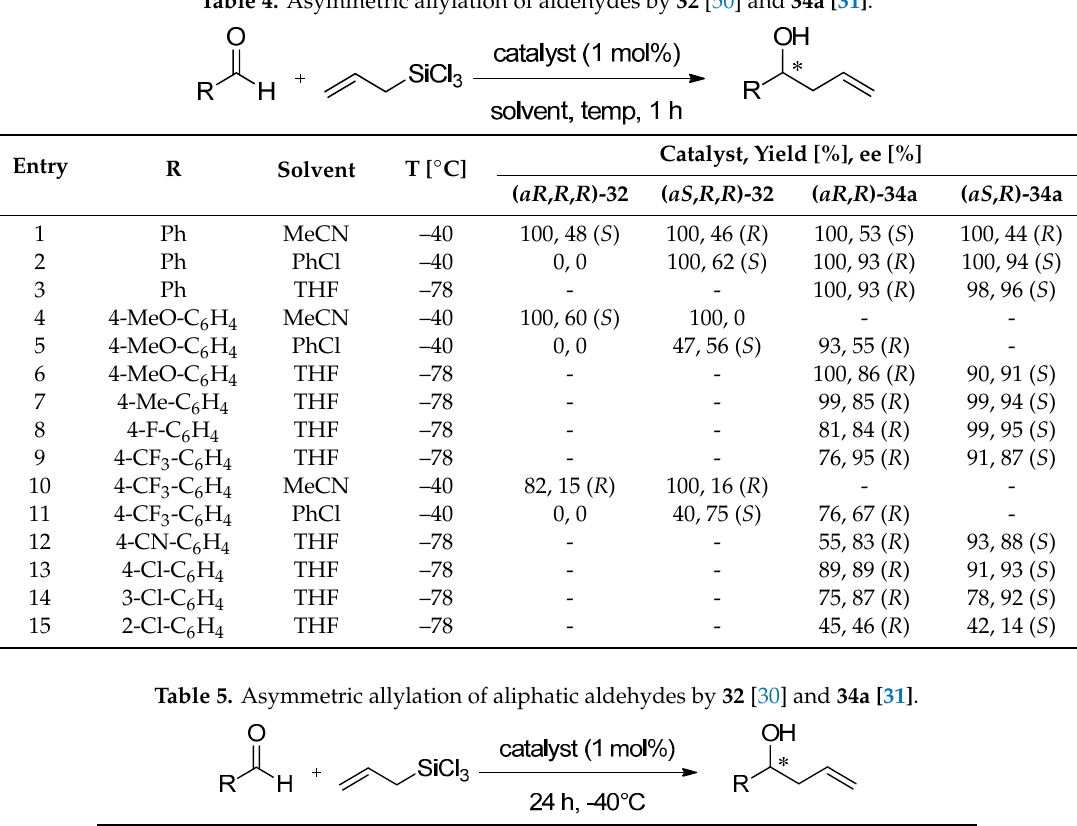
Table 4. Asymmetric allylation of aldehydes by 32 [50] and 34a [31].